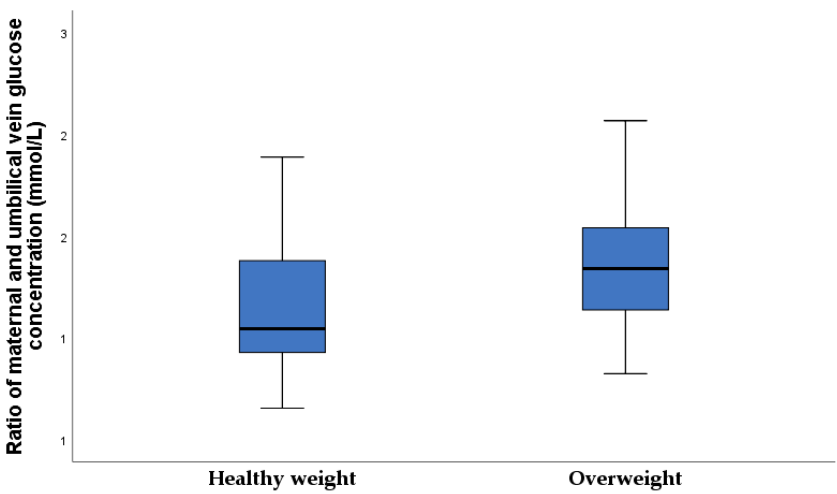
Figure 2. The maternal and umbilical vein glucose concentration ratio in two study groups (healthy- weight neonates 1.2 ± 0.3, overweight neonates 1.4 ± 0.7; p = 0.021). Significant nonparametric correlations were found between maternal venous serum and umbilical vein C-peptide concentrations (r rho = 0.566, p < 0.001) (Figure 3). The difference between maternal and umbilical glucose concentration was significantly higher in overweight than in healthy-weight newborns (1.34 (1.14–1.54): 1.04 (0.93–1.38), p = 0.012).